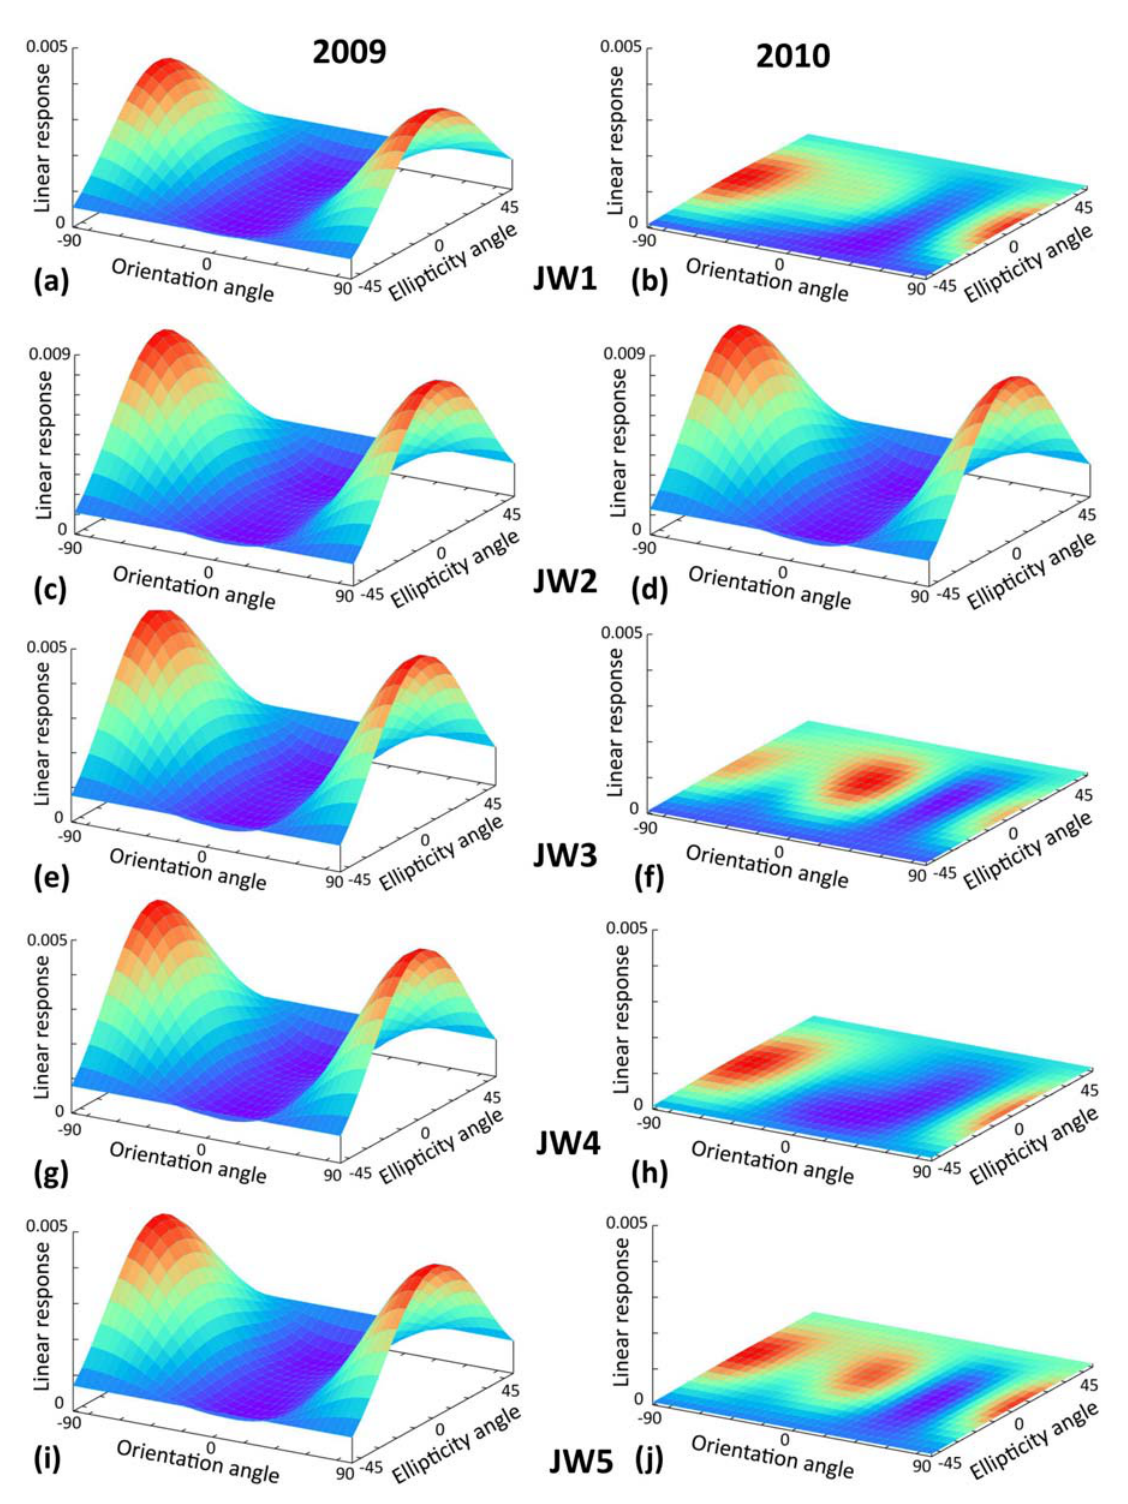
Figure 15. Plots of polarimetric signatures of water at locations shown in Figure 11 for the 2009 and 2010 flight lines. Note the difference in vertical scale in c and d plots. Orientation angles near ± 90 ° signify vertical scattering, while angles near 0 ° signify horizontal scattering components dominated the water surface backscatter. Ellipticity values near zero denote linear while those near ± 45 ° denote circular